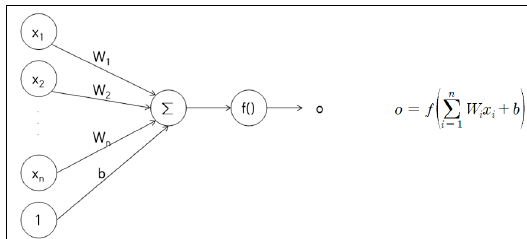
Figure 1. Neuron structure of artificial neuron network (ANN).